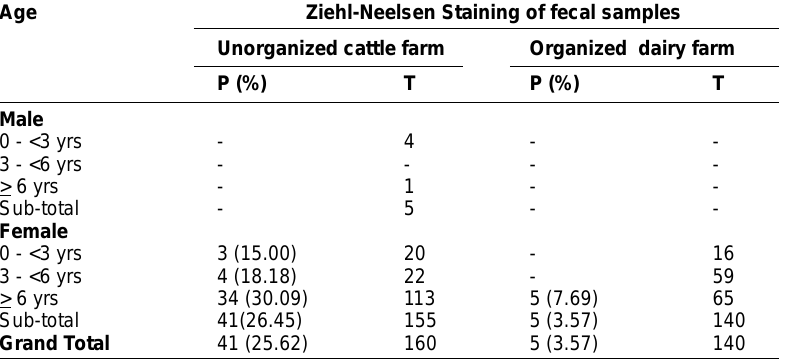
Table-2. Number of JD positive case from unorganized cattle farm and organized dairy farm with respect to age and sex. ZN staining was used to screen the fecal smears, prepared from decontaminated fecal samples (with 0.75% HPC). Figure in parentheses indicate percentage. P = No. of positive samples, T = Samples tested.